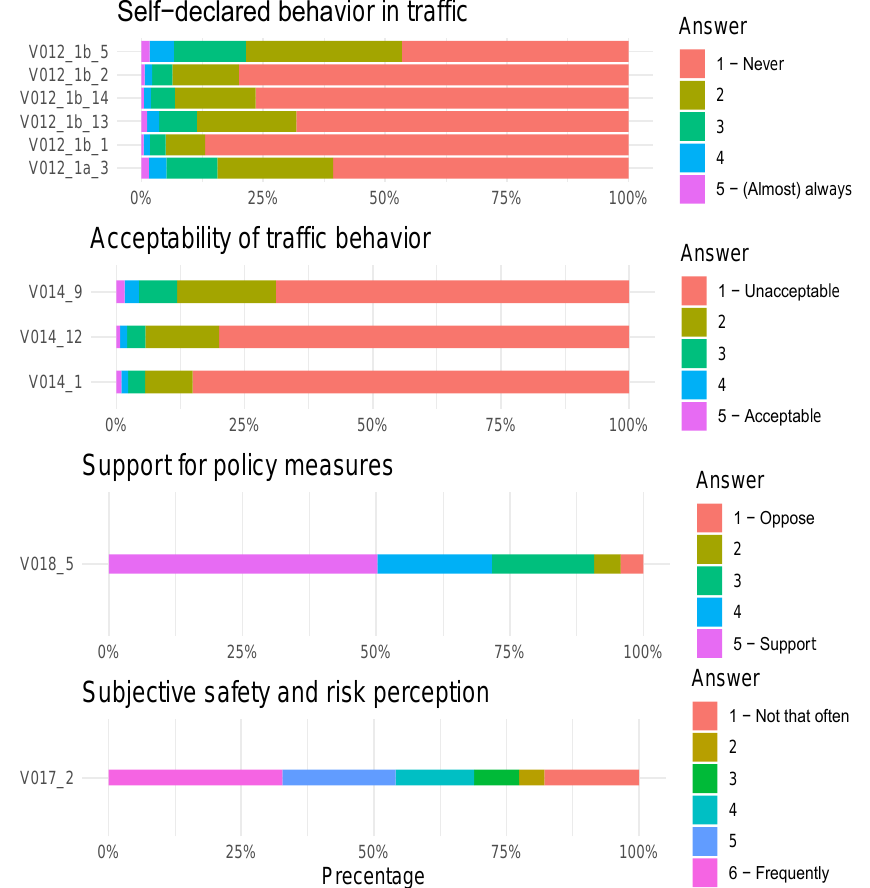
Figure 1. Distribution of answers to ESRA2